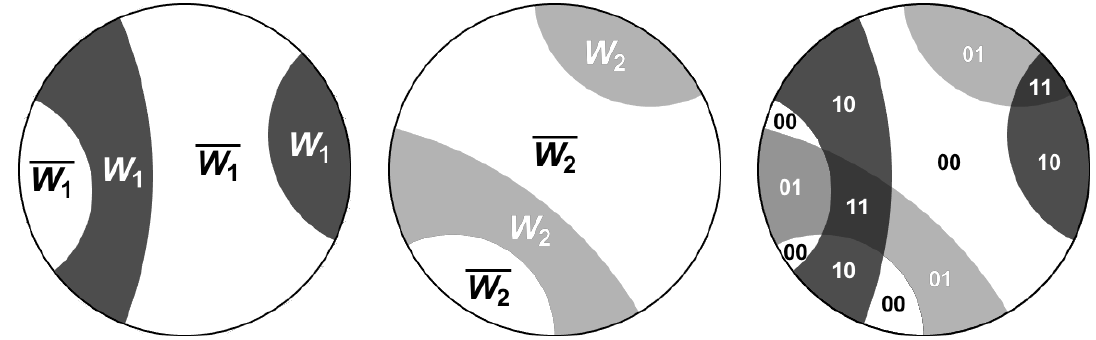
Figure 4 . Two examples of regions W l (left and center) and the regions W ( ~x ) labeled with the components of ~x